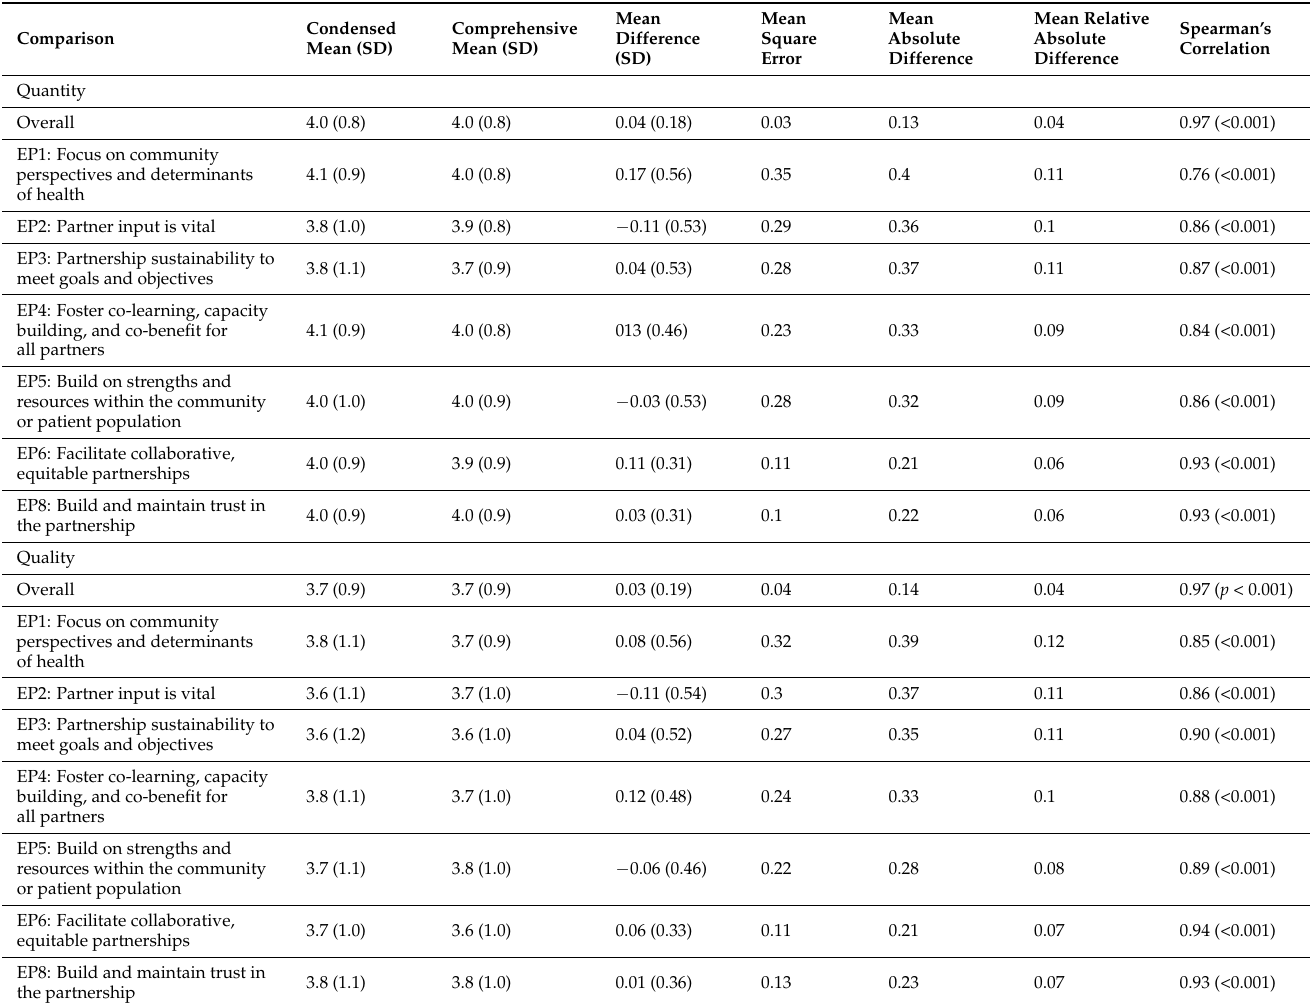
Table 3. Condensed REST and Comprehensive REST Comparison by Engagement